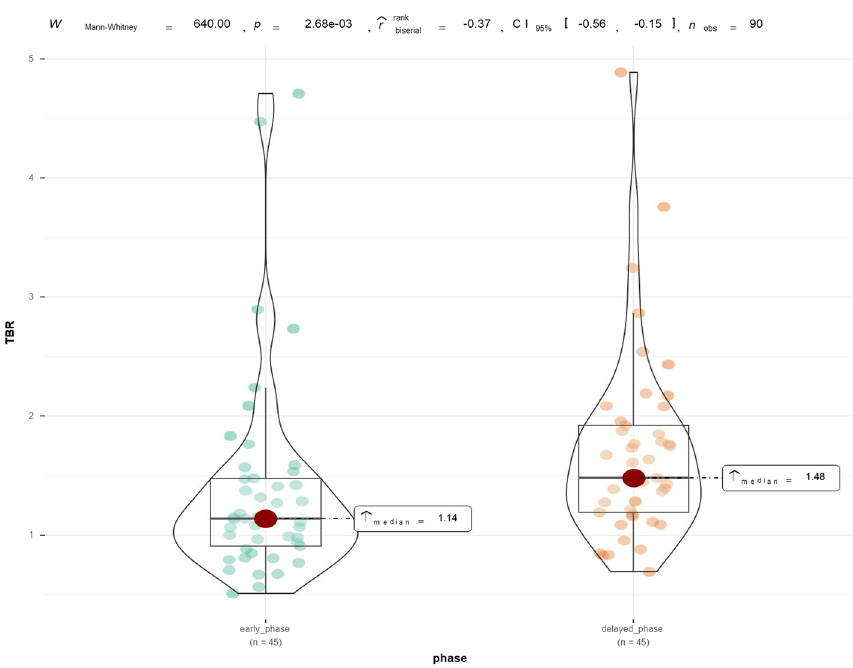
Fig. 3 Violin plot analysis comparing the TBR of parathyroid lesions in early-phase and delayed-phase images. The green group represents the early phase, whereas the orange represents the delayed phase. The red oval indicates the median value, while the size of the black box indicates the first and third quartile ranges. The rank-sum test of independent samples was used, and the TBR level in the delayed phase was significantly higher than in the early phase ( P < 0.001). TBR is the tumor-to-background counts ratio